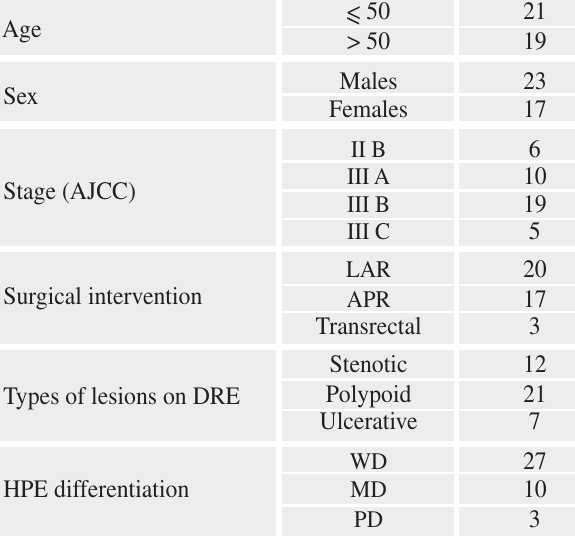
Table I: Patient characteristics (N=40)(cid:13)